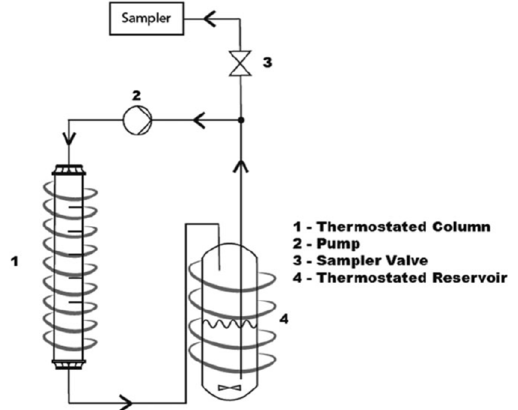
Figure 12. Schematic representation of the flow reactor based on HNTs developed for 4-NP reduction. Reproduced with permission from ref. [84]. Copyright 2018 John Wiley and